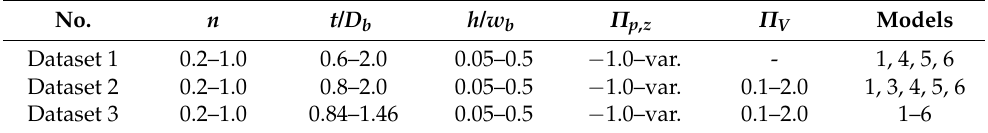
Table 7. Overview of the parameter ranges of the datasets and the models used in each case.